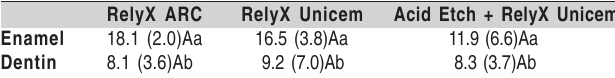
regarding the resin luting protocol (p>0.05). These results are shown in Table Table 2. Means and standard deviations (in MPa) of microtensile bond strength for the tested groups.